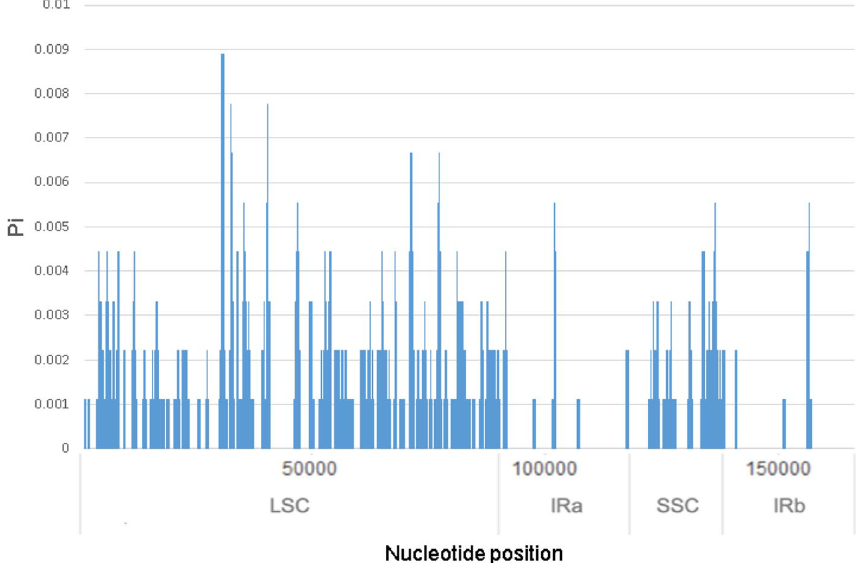
Figure 5. Comparative analysis of nucleotide diversity (Pi) values among the three Adinandra species cp genome sequences.